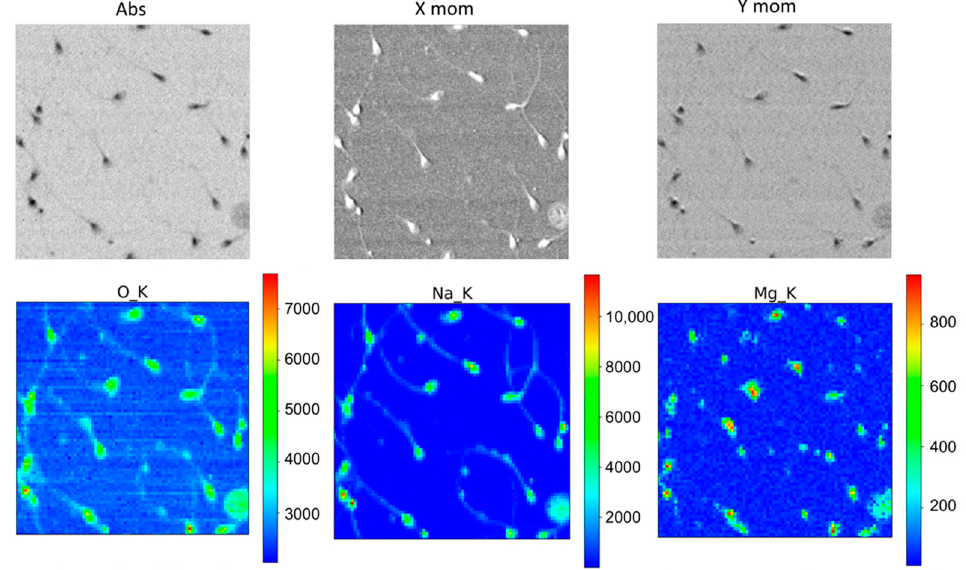
Figure 7. Absorption (Abs) and differential phase contrast in X (X mom) and Y (Y mom) images of spermatozoa deposited on Si 3 N 4 windows, depicted with the corresponding XRF maps of O, Na, and Mg. The maps were collected at 1.5 keV over an area of 80 µ m × 80 µ m with a 400 nm and 1 µ m step size for STXM images and XRF, respectively, and a 10 s/pixel acquisition time for XRF. Scale bar is 10 µ